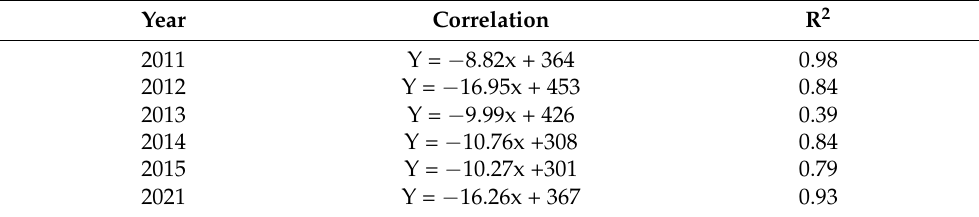
Table 2. Correlations between Si(OH)4 and station position, from Stations 11–17. See Figure 5c.